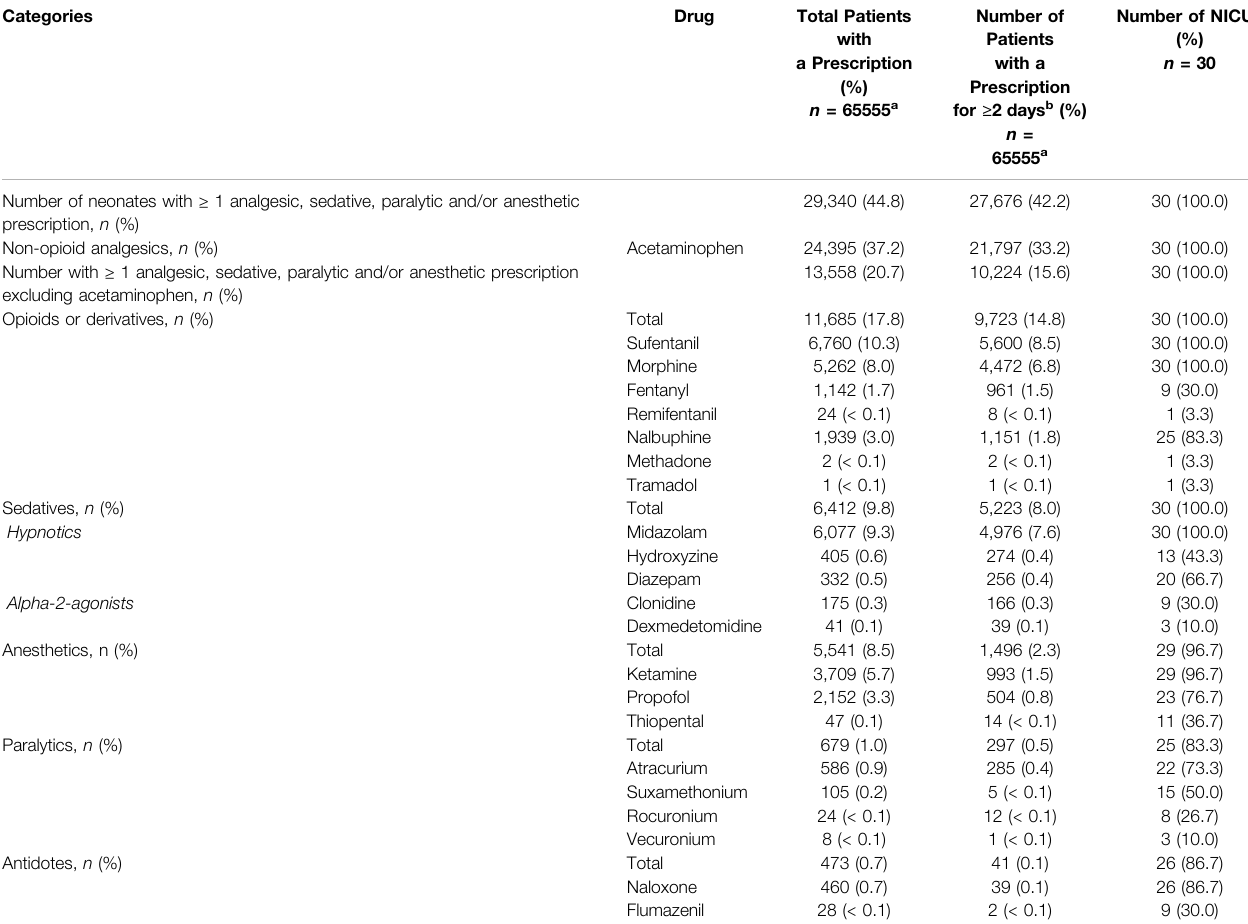
TABLE 1 | Frequencies of patients and units with prescriptions of analgesic, sedative, anesthetic, paralytic, and antidote drugs.